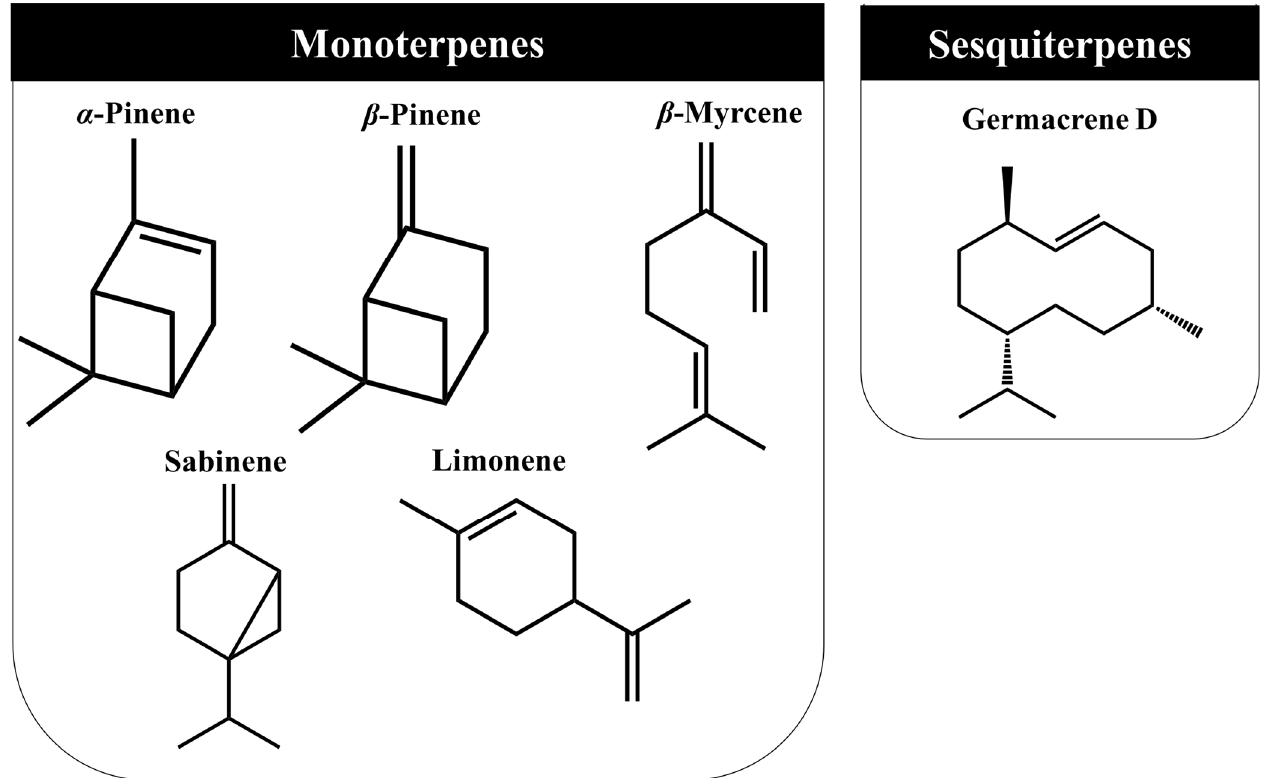
Figure 4. The main volatile organic compound found in Juniperus communis L. parts.